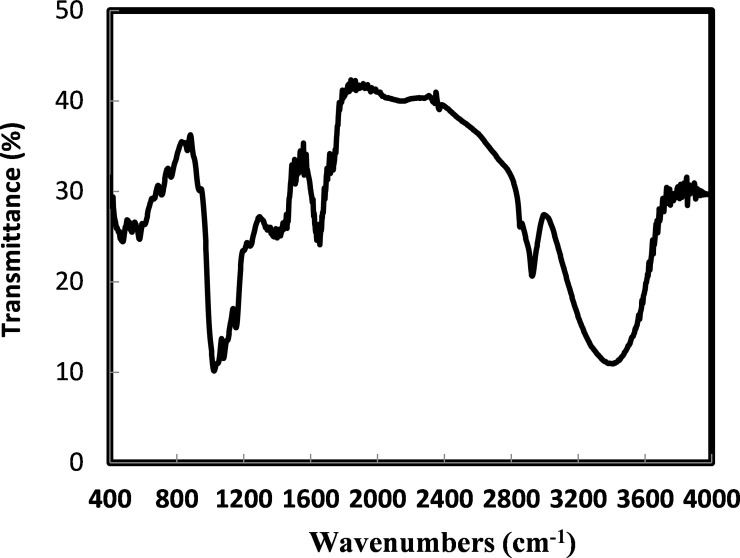
FTIR spectra of RH.